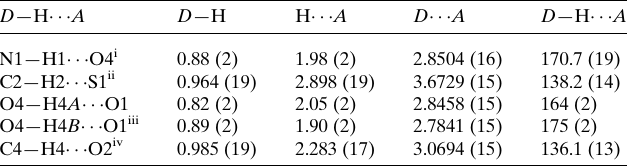
Table 1 Hydrogen-bond geometry (A˚ , (cid:3) ).